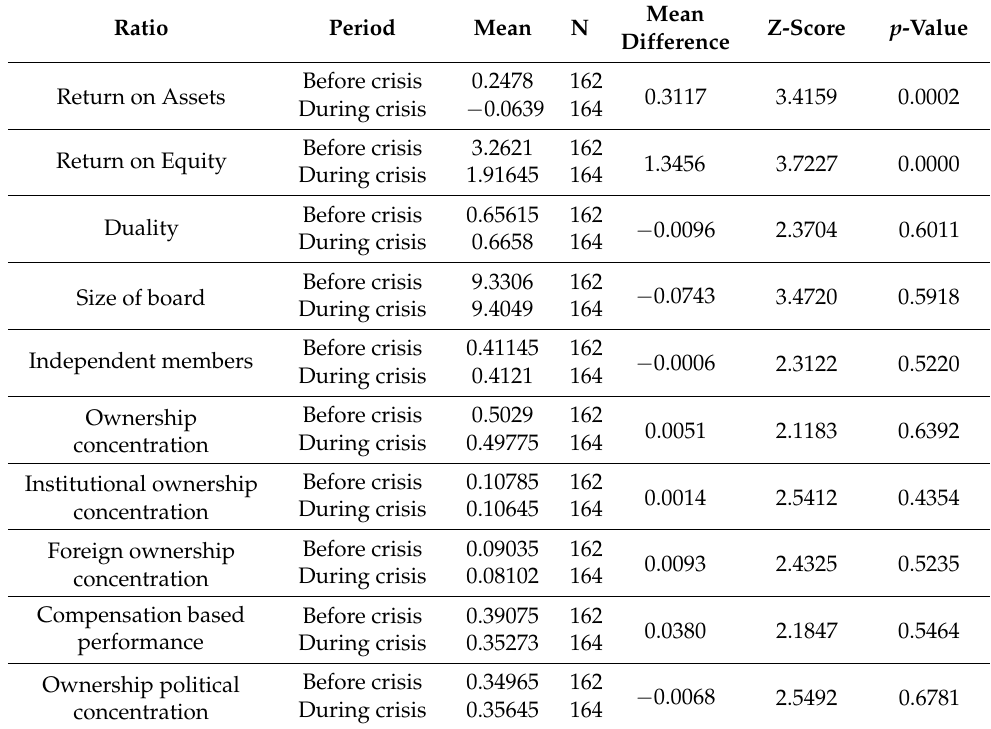
Table 8. Mann–Whitney U Test